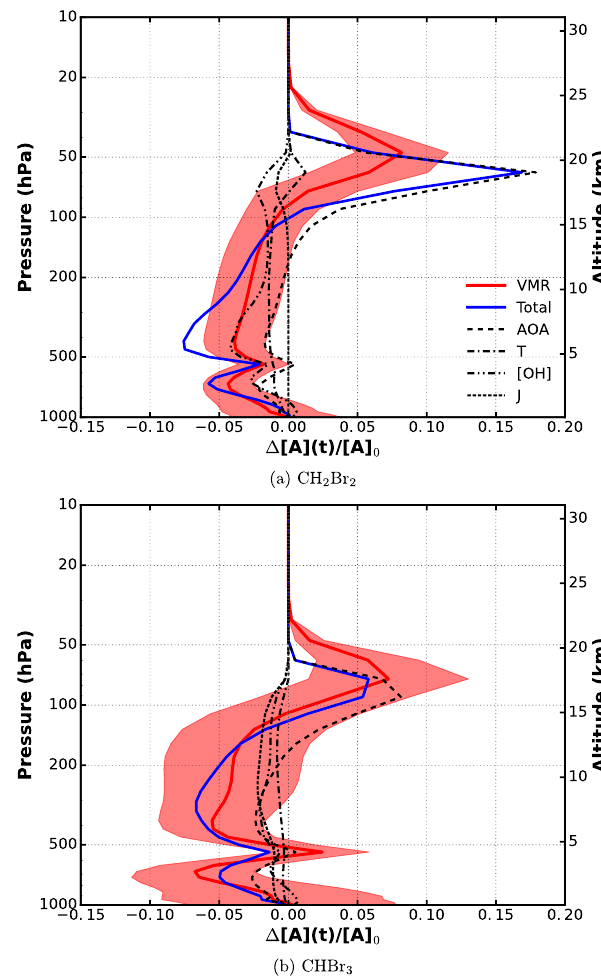
Figure 7. Relative difference of VSLS vertical profiles for 2000 and 2100. Major influences on lifetime have been separated. Shown are resulting profiles by varying the denoted variables, mean tempera- ture T , OH concentration [OH], photolysis frequency J , and age of air (AOA), in Eq. (3) one by